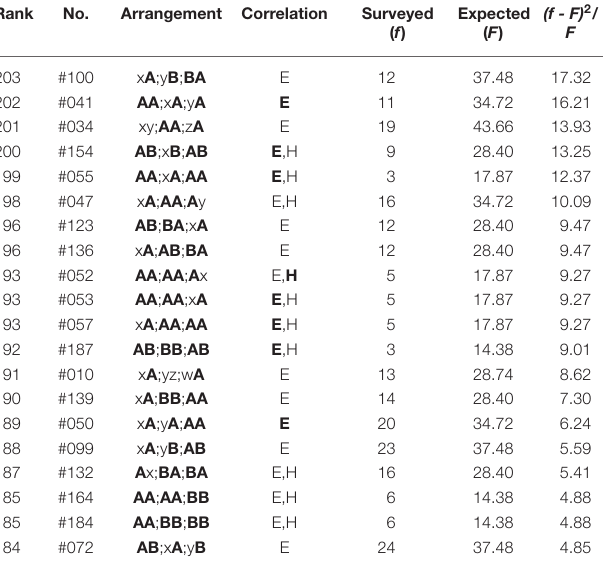
TABLE 1 | The top-twenty arrangements in The Complete Haiku Works of Mantaro Kubota , wherein there are 6064 poems included. Rank No. Arrangement Correlation Surveyed